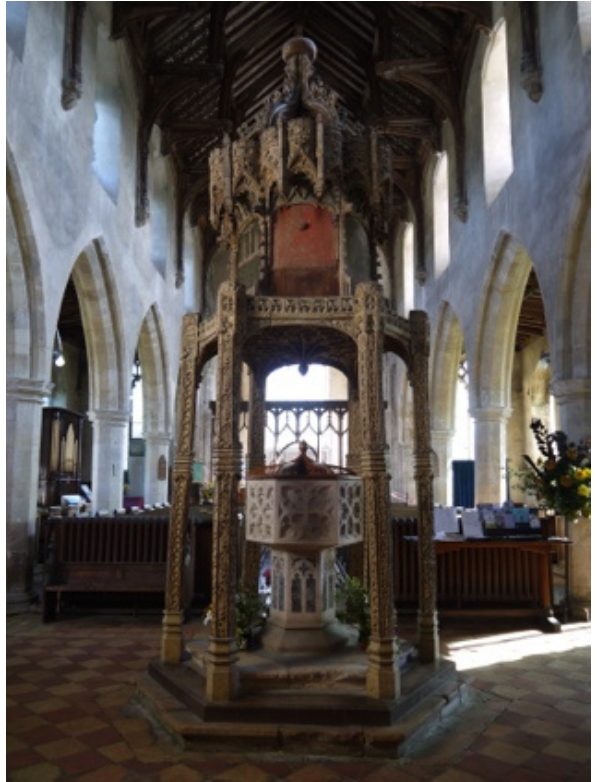
Figure 6. The font at St Botolph’s at Trunch.